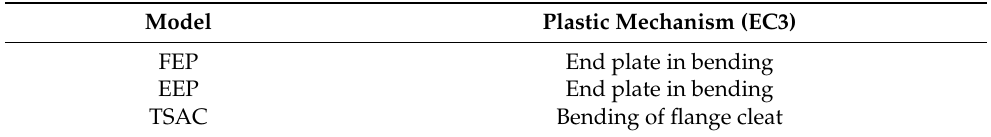
Table 4. Plastic mechanisms calculated according to